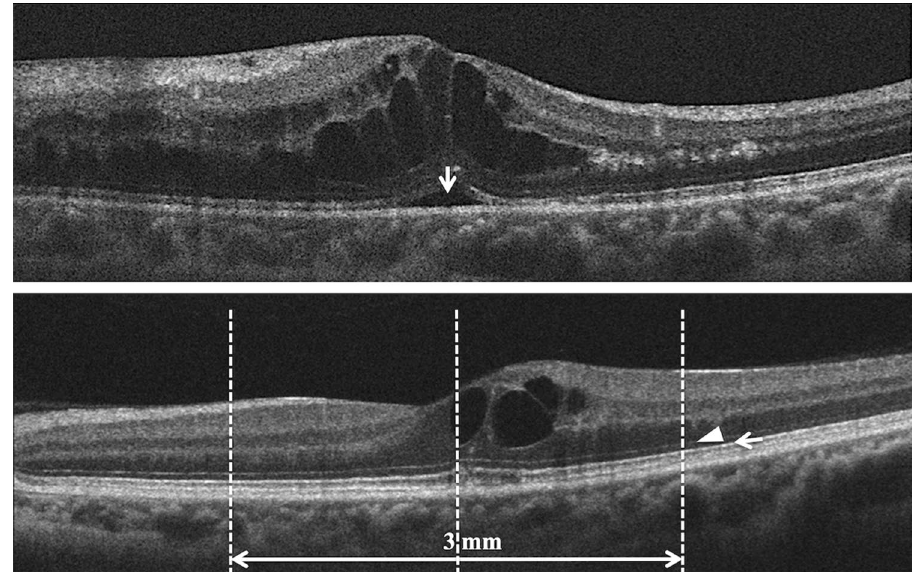
Figure 3. (Top) Based on optical coherence tomography (OCT) images in patients with branch retinal vein occlusion (BRVO), we evaluated the presence of the serous retinal detachment (arrow) before treatment. (Bottom) Based on post-treatment OCT images, we assessed the status (absence or intact) of the external limiting membrane (arrowhead) and the ellipsoid zone (arrow) at the region of 3 mm on the vertical section through the foveal